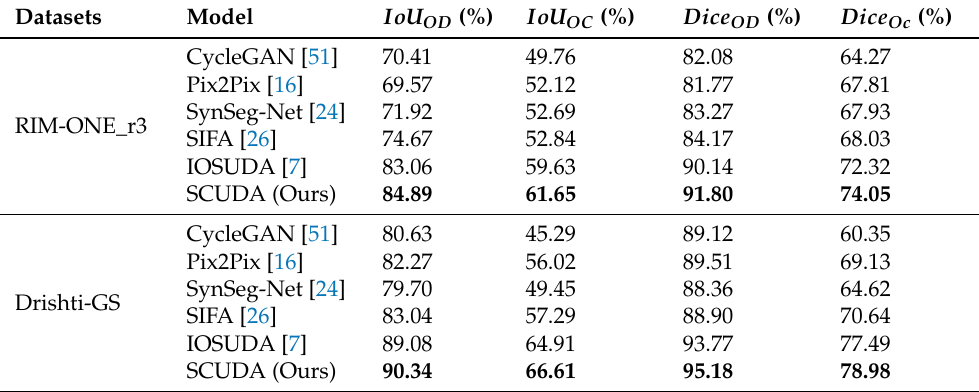
Table 3. Comparative experimental results of CycleGAN, Pix2Pix, SynSeg-Net, SIFA, IOSUDA, and our proposed SCUDA on the RIM-ONE_r3 test set and the Drishti-GS test set.